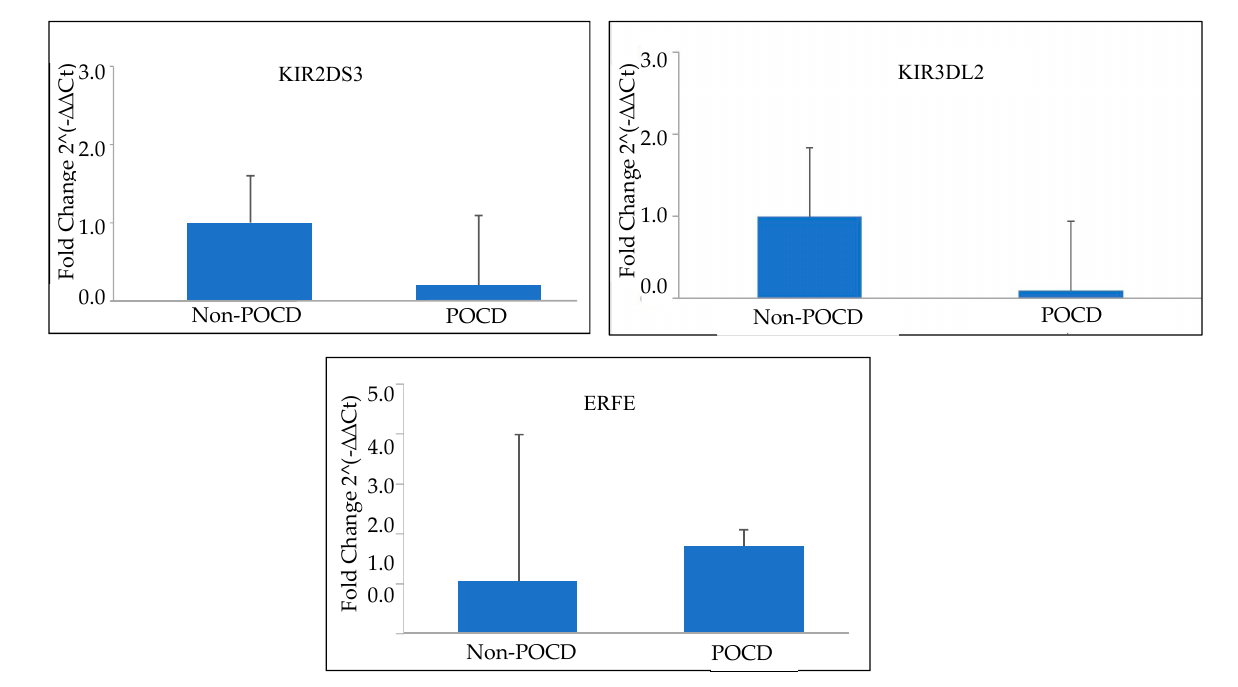
Figure 4. Bar graphs representing expression levels of KIR2DS3, KIR3DL2, and ERFE genes by quantitative real-time RT-PCR in POCD and non-POCD groups define by their fold change.